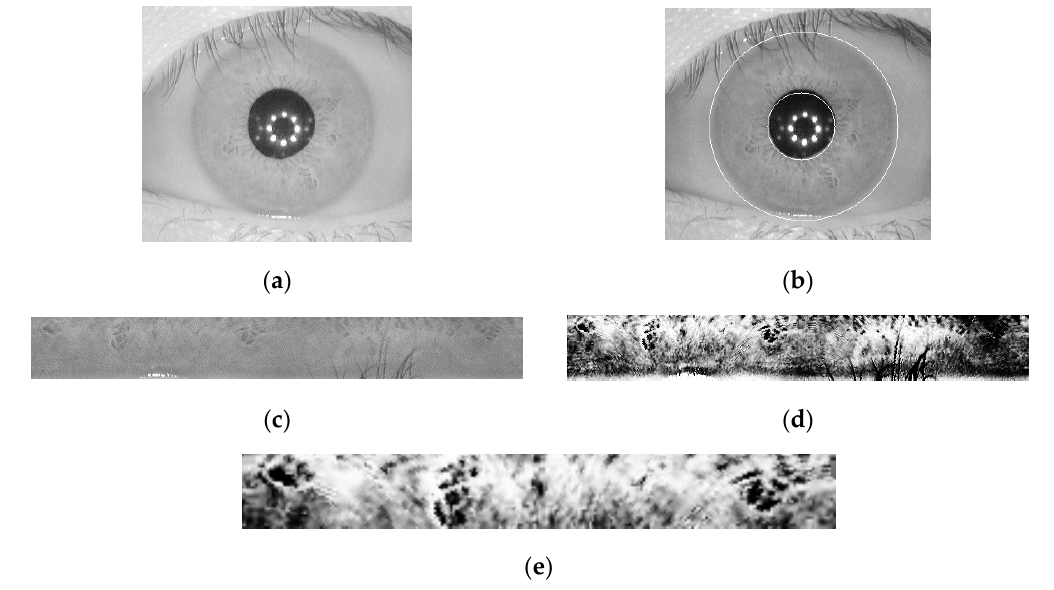
Figure 1. Results of each step of the iris-processing stage: ( a ) quality qualified image; ( b ) iris area (two inner regions of the white ring); ( c ) normalized image; ( d ) enhanced image; ( e ) recognition area.